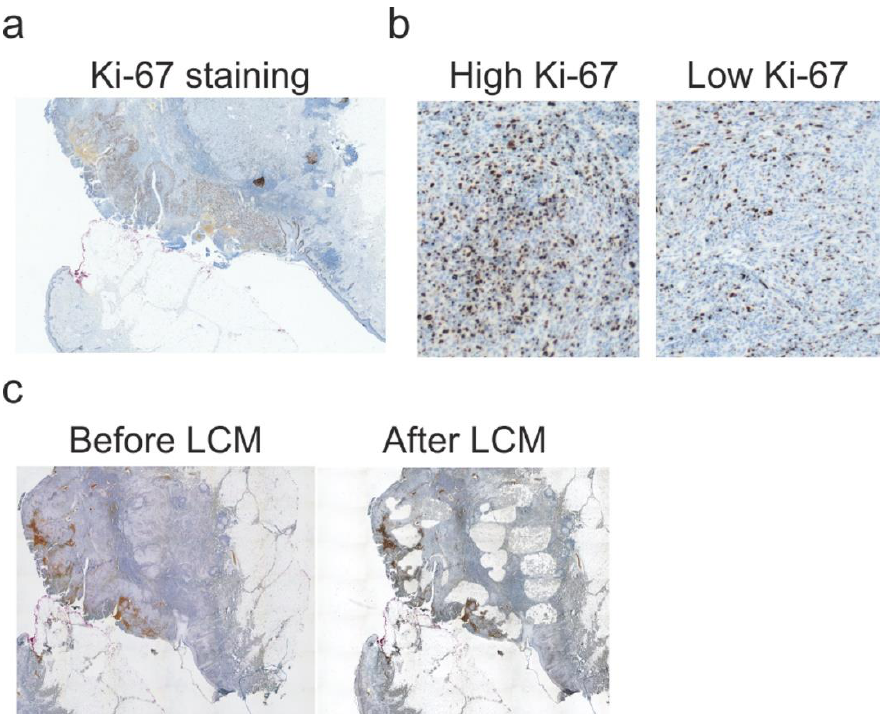
Figure 2. Laser-capture microdissection of chosen compartments of tumor tissue. ( a ). Representative Ki-67 staining of melanoma tissue. Magnification 5 × . ( b ). Representative Ki-67 staining of high proliferation (HP) and low proliferation (LP) compartments. HP and LP fragments were defined as a compartment of tumor tissue with a higher or lower density of Ki-67-positive cells compared to the mean density of whole tumor slices. Magnification 20 × . ( c ) Scans of the samples before and after laser-capture microdissection (LCM). Magnification 5 × .